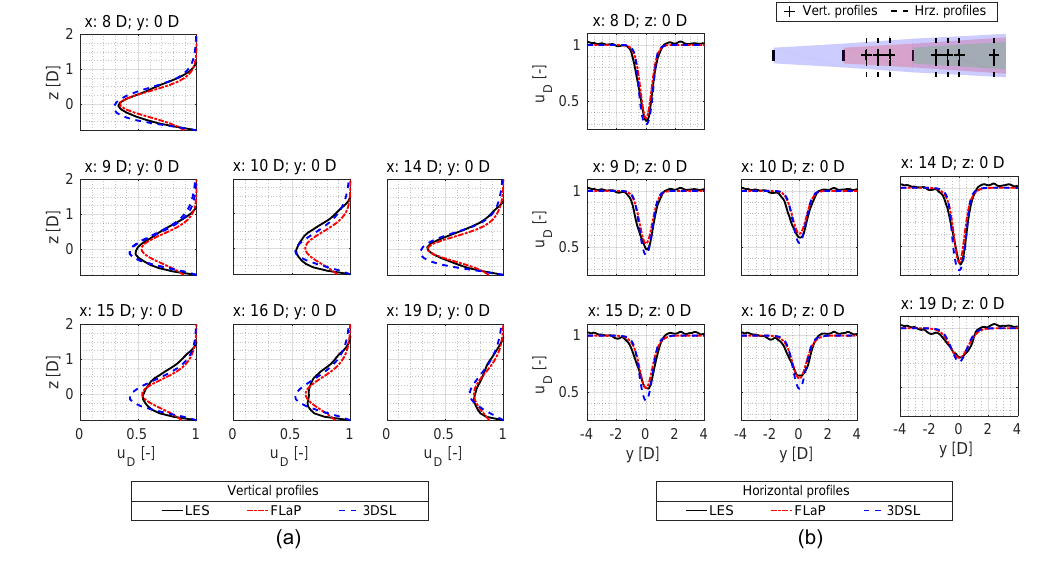
Figure A2. Test case 2 (multiple aligned wakes). Downstream de- velopment of the vertical (a) and horizontal (b) profiles of the wake velocity evaluated along the common axis of the wind turbines from the 3DSL model and FLaP simulations and from the reference large-eddy simulation (LES) wind field. The position of the profiles considered is illustrated in the top right corner of (b) .